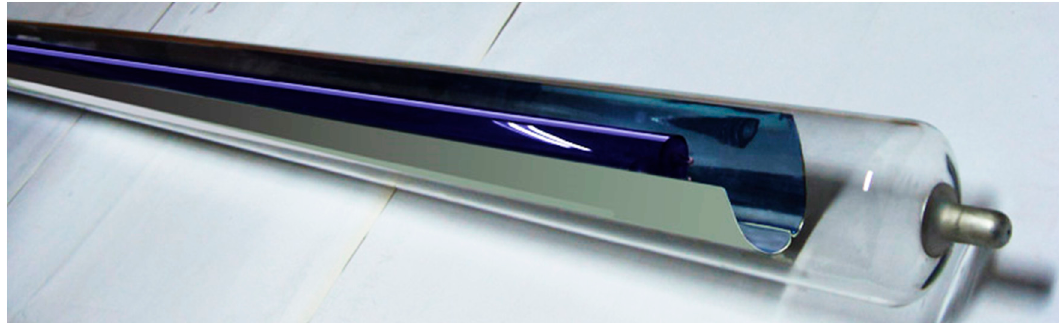
Figure 16. Collector with new V-shaped CPC, heat pipe, and inner reflector [30].